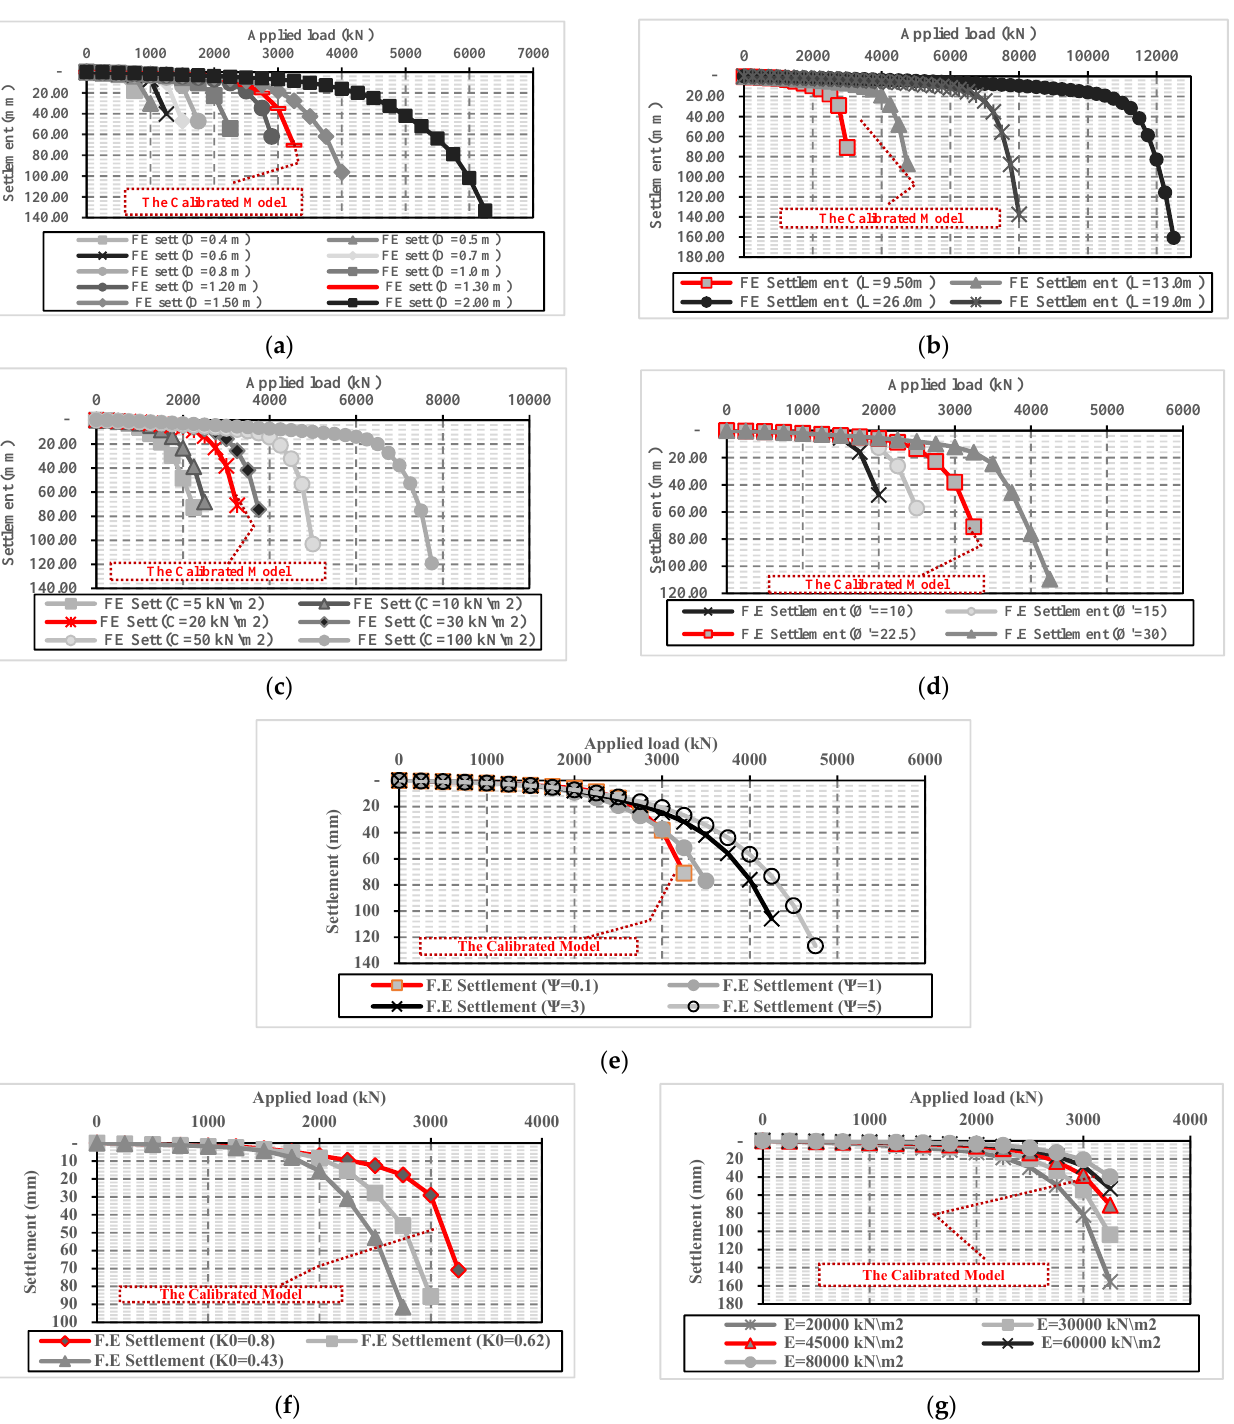
Figure 4. Effect of the pile geometrical and soil geotechnical parameters on the load settlement relationship. ( a ) Pile diameter (D). ( b ) Pile length (L). ( c ) Effective cohesion (c’). ( d ) Effective friction angle (Ø’). ( e ) Dilatancy angle ( Ψ ). ( f ) Lateral earth pressure coefficient (k 0 ). ( g ) Young’s modulus (E s ).